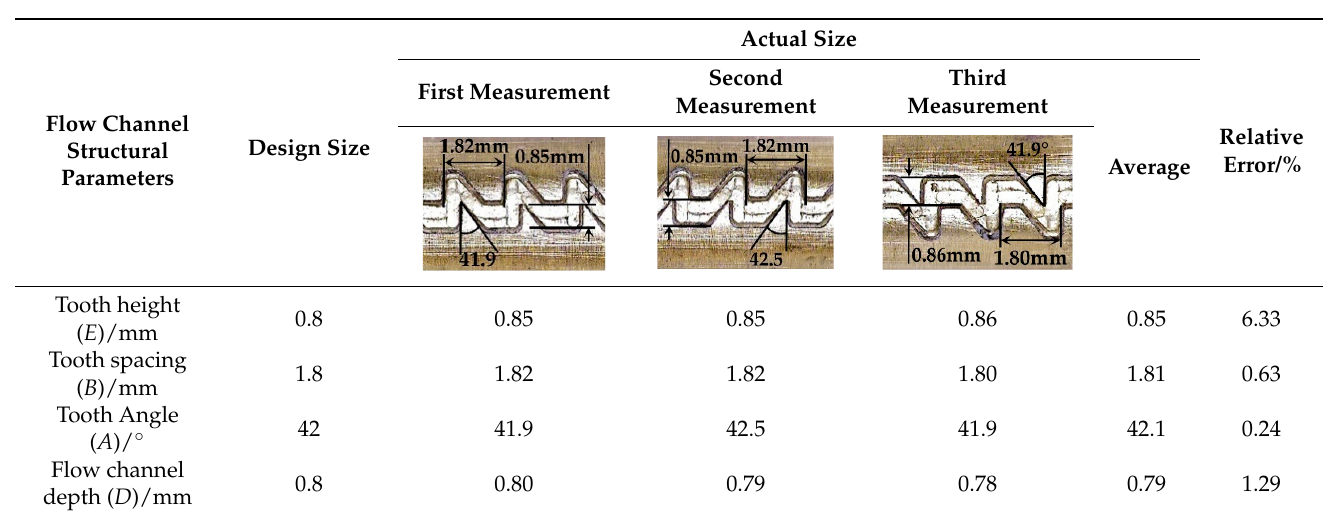
Table 9. Comparison of the actual and design size of the flow channel structure of the processed